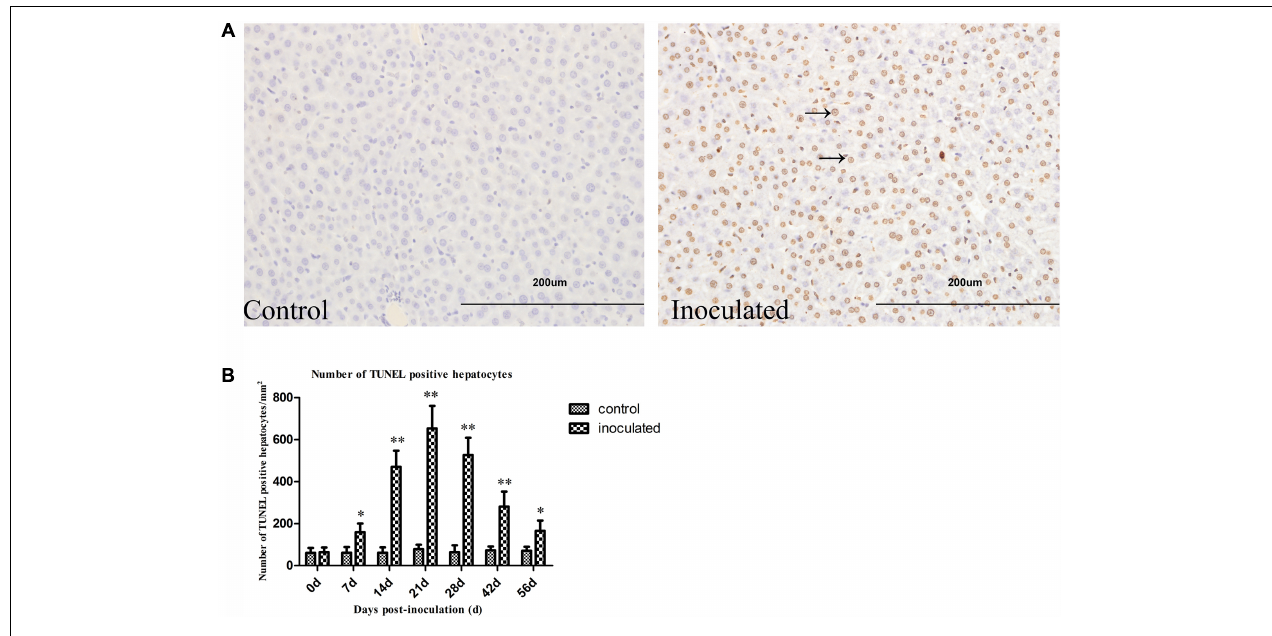
FIGURE 4 | Hepatitis E virus infection induced TUNEL positive hepatocytes increased. (A) Representative pictures of TUNEL staining (arrow indicates TUNEL-positive hepatocytes nuclear stained in brown). (B) Quantitative analysis of number of hepatocyte apoptosis (/mm 2 ). ∗ p < 0.05, ∗∗ p < 0.01.